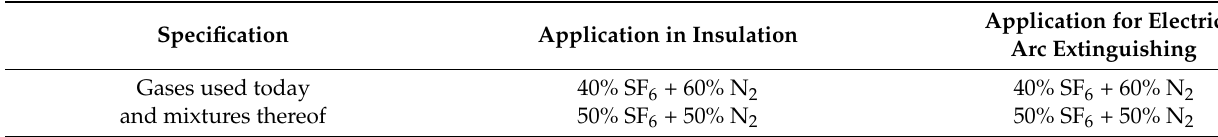
Table 2. Predicted directions of research for gas mixtures used in power engineering